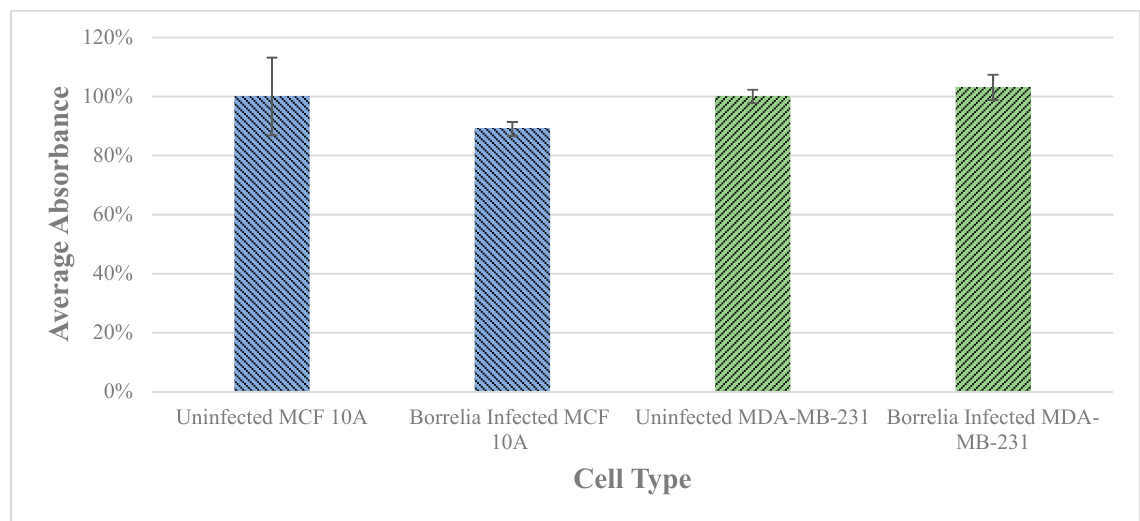
Figure 3. The effect on cell proliferation of MCF 10A an MDA-MB-231 epithelial cells after infection with B. burgdorferi versus uninfected breast epithelial cells after 72 h determined by a cell viability assay as described in Material and Methods. The error bar represents a standard error of mean (SEM). All experiments were performed a minimum of three independent times with at least six samples per experiment ( n =